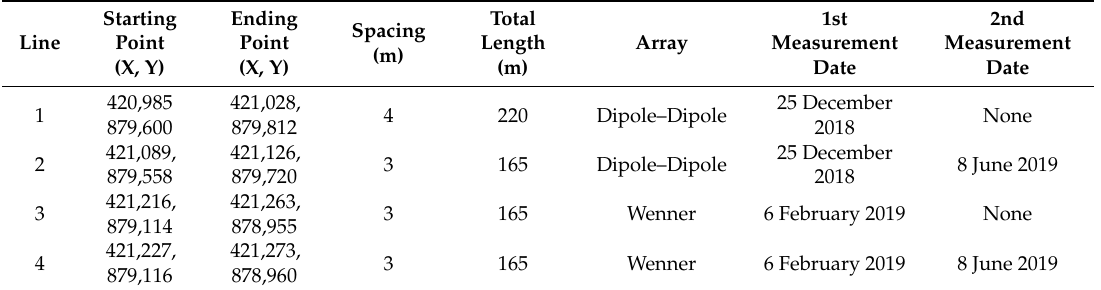
Table 1. Soil sample measurement to determine the resistivity for seawater intrusion in